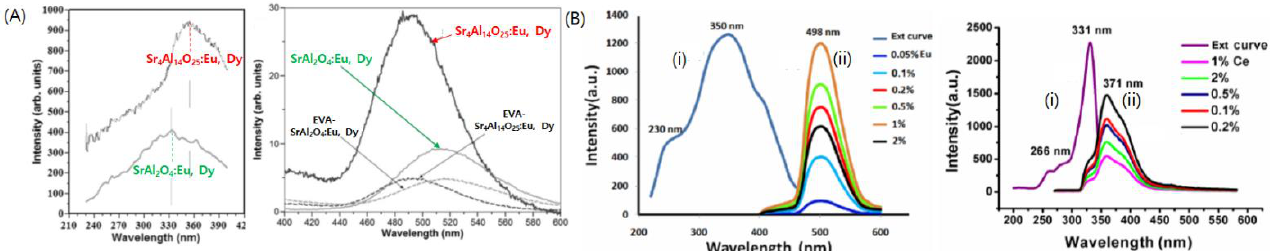
Figure 1. Photoluminescence spectra for lanthanide doped strontium aluminate phosphors ( A ) Photoluminescence excitation (left) and emission (right) spectra for SrA 2 O 4 :Eu 2+ , Dy 3+ and Sr 4 Al 14 O 25 :Eu 2+ , Dy 3+ . Reprinted from [61] with permission from Elsevier. ( B ) Photoluminescence excitation (i) and emission (ii) spectra for SrA 2 O 4 :Eu 2+ (left) and SrA 2 O 4 :Ce 3+ (right). Adapted from [30] under Creative Commons Attribution (CC BY) license.